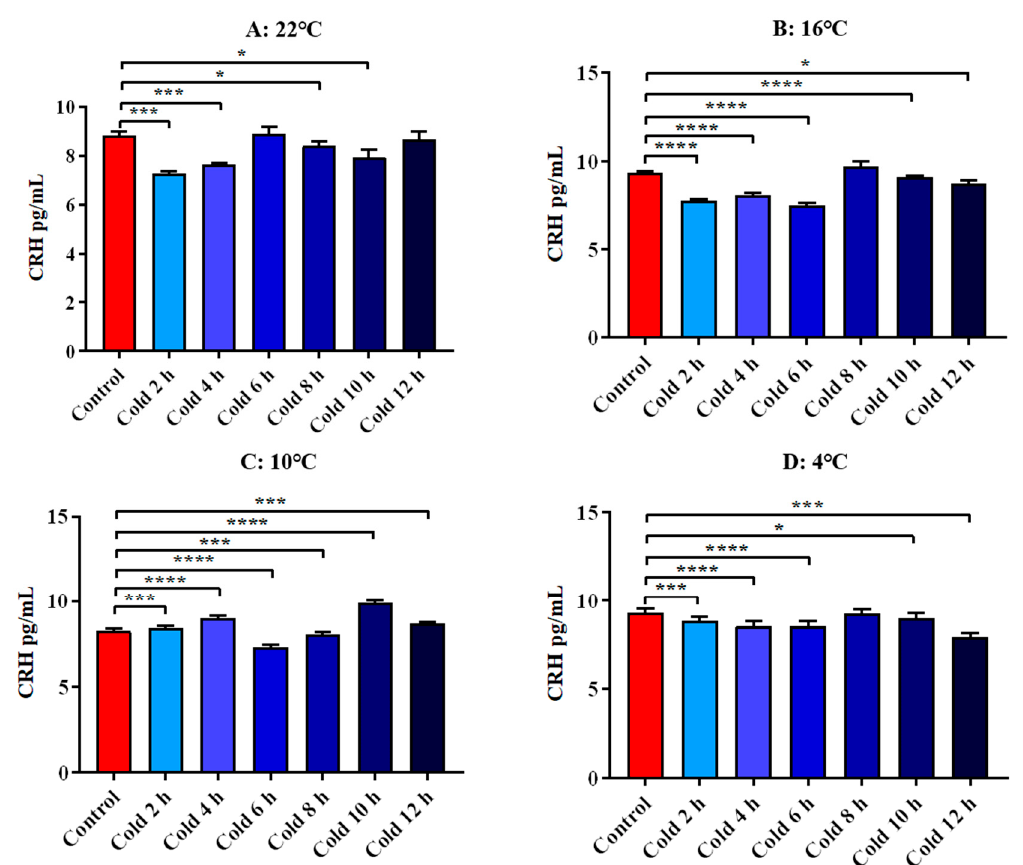
Figure 9. Changes in serum CRH of ICR mice under different intensity of cold exposure. ( A ). Changes in the serum CRH of mice under cold exposure at 22 ◦ C; ( B ). Changes in serum CRH of mice under cold exposure at 16 ◦ C; ( C ). Changes in the serum CRH of mice under cold exposure at 10 ◦ C; ( D ). Change in the serum CRH of mice under cold exposure at 4 ◦ C. Compared with 28 ◦ C normal temperature control group, the difference was significant as * p < 0.05. *** p < 0.001. **** p < 0.0001.